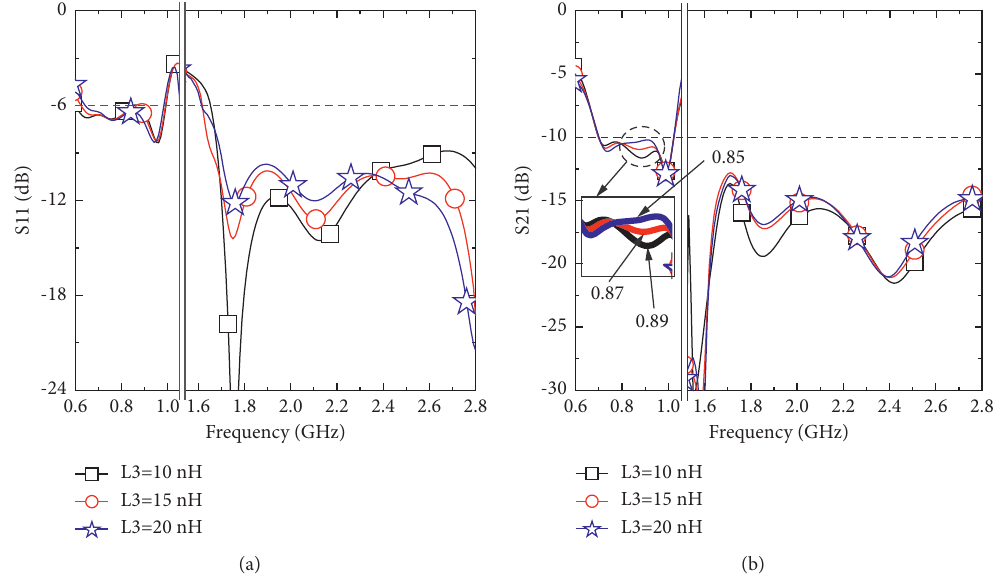
Figure 6: Simulated S-parameters of the proposed antenna with different values of L3. (a) S11. (b)